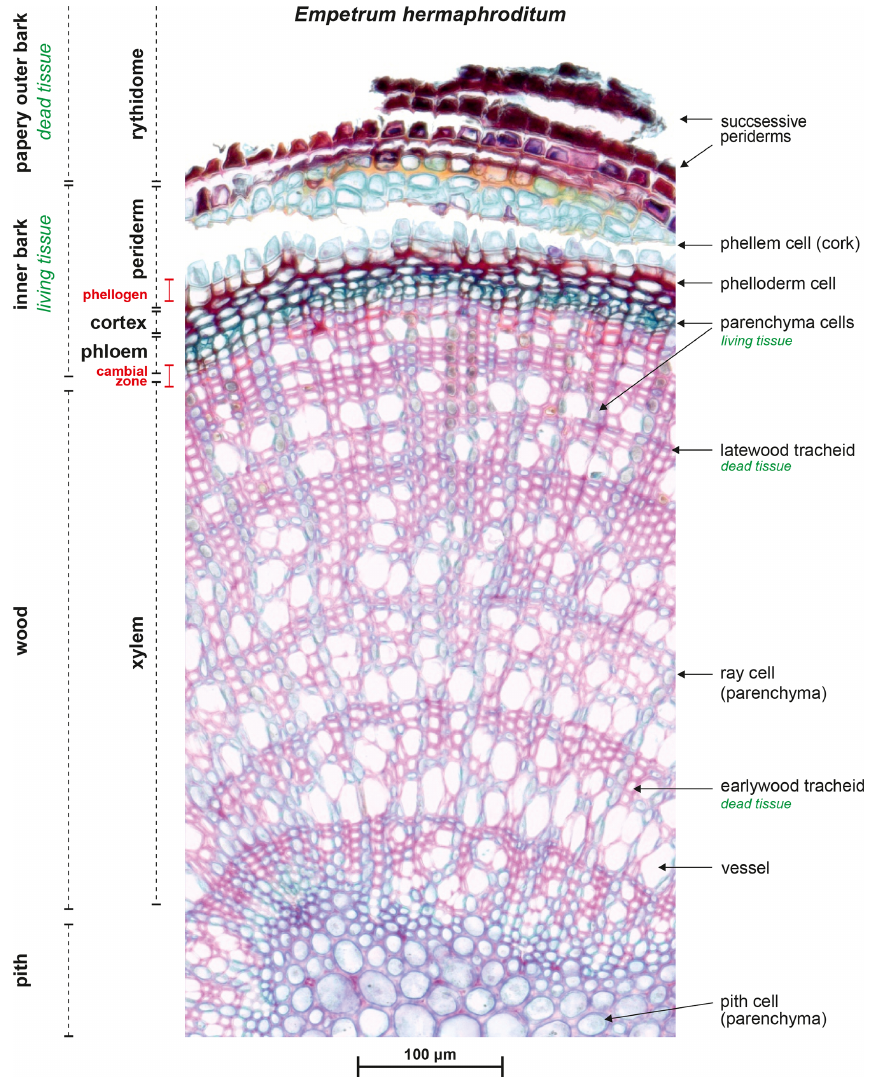
Figure A1. Radial micro-slide of a stem from Empetrum nigrum ssp. hermaphroditum (1:1000 magnification). The outermost layers of the papery outer bark, which repeat the successive pattern of the shown periderm, were lost while cutting. In our dendrometer approach, we removed the outer layers of the bark, most likely down to the phellogen. As shown here, the loose bark structure allows removal without severe damage of the inner tissue. We aimed at mounting our dendrometer sensor as close to the still protected cambial zone to obtain data on physiologically active stem diameter variability such as growth, excluding swelling and shrinking of the passive outer bark